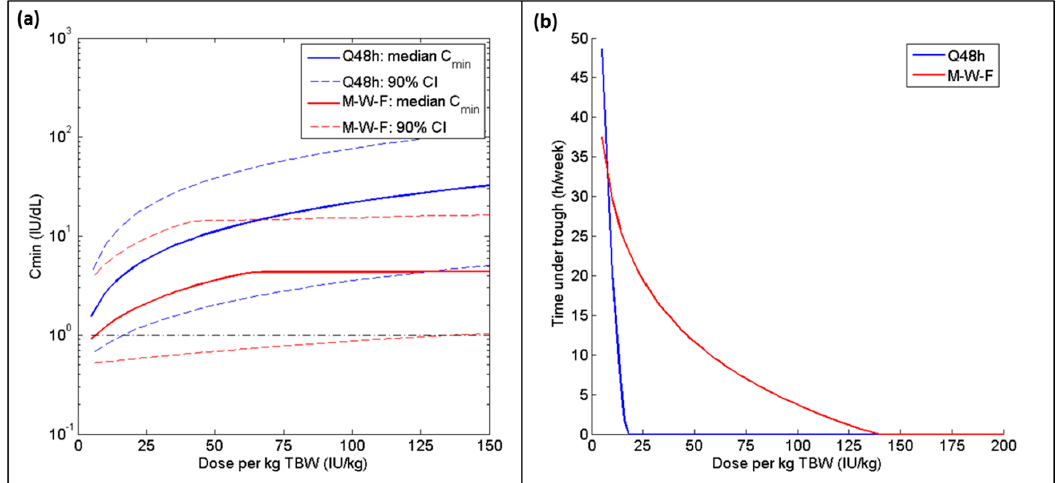
Figure 3. ( a ) Median and 90% confidence intervals for C min and ( b ) 95th quantile for time spent below 1 IU dL − 1 (hours per week) for TBW-based dosing regimen administered at different intervals for the combined group (normal + overweight/obese) for both Q48 h (blue) and Monday-Wednesday-Friday (red) dosing schedules. For the Q48 h regimen, all doses are increasing along the X -axis; for the Monday-Wednesday-Friday schedule, only the Friday dose is changing (Monday and Wednesday doses are fixed at 20 IU per kg TBW).